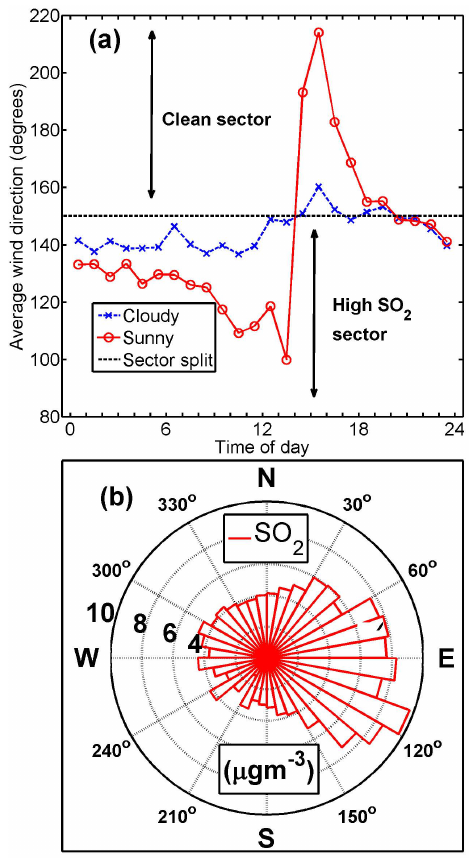
Fig. 3. The diurnal cycle of wind direction and wind direction de- pendence of SO 2 . (a) Diurnal cycle of average wind direction and (b) the average sulphur dioxide (SO 2 ) mass concentrations mea- sured at the Osasco monitoring station in each wind direction sec- tor. The average wind direction was split into a clean sector and a sector associated with elevated concentrations of SO 2 indicated by the dashed